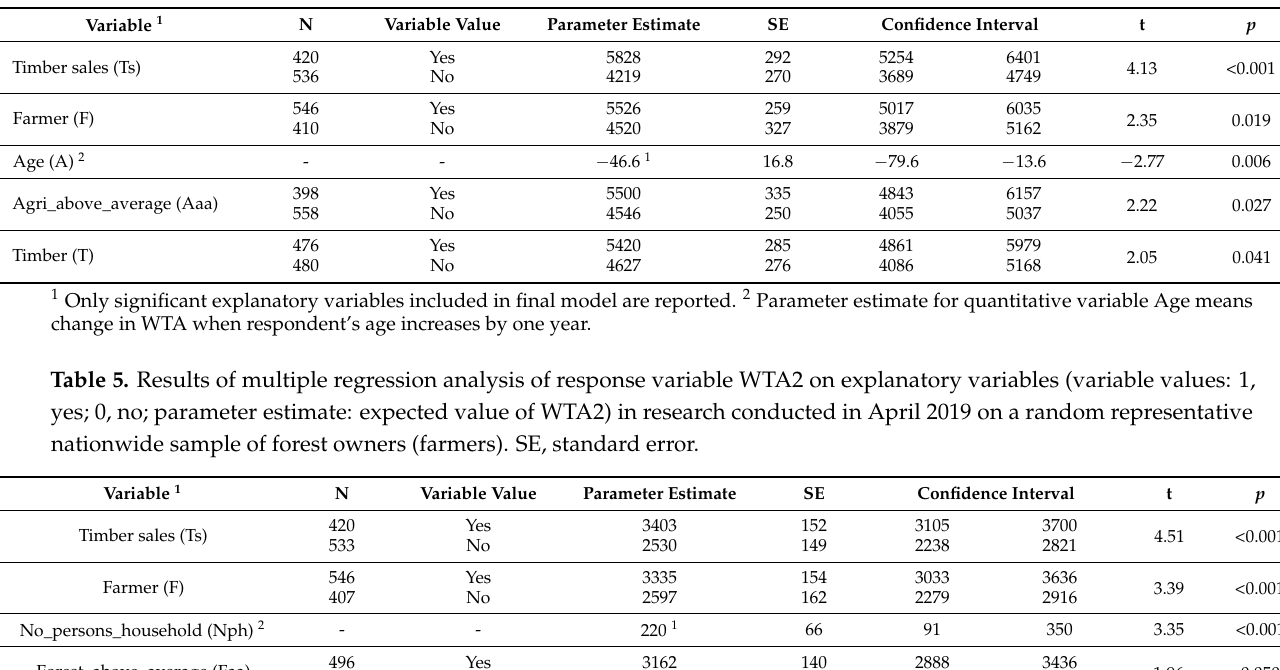
Table 4. Results of multiple regression analysis of response variable WTA1 on explanatory variables (variable values: 1, yes; 0, no; parameter estimate: expected WTA1 value) in research conducted in April 2019 on a random representative nationwide sample of forest owners (farmers). SE, standard error.